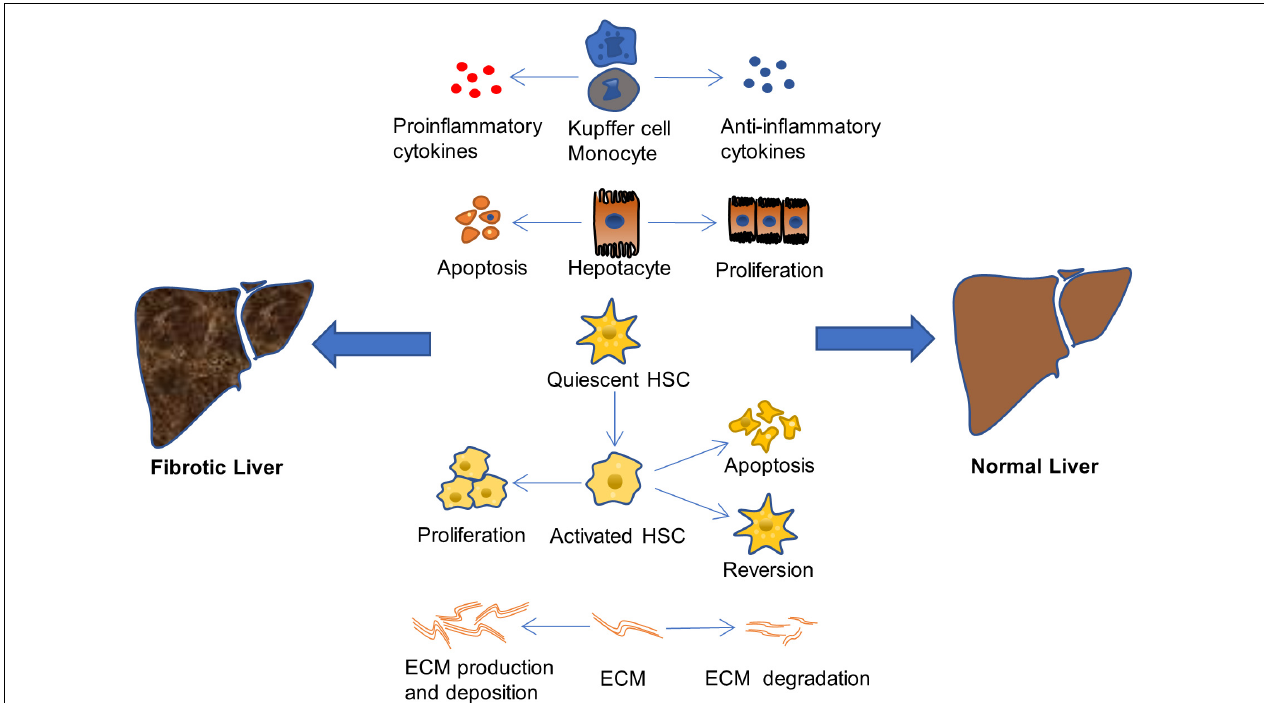
FIGURE 2 | Therapeutic approaches of liver fibrosis. The liver fibrosis is induced when the balance of pro-inflammatory/anti-inflammatory, or apoptosis/proliferation of hepatocyte and HSCs, or production and deposition/degradation of ECM is destroyed (Campana and Iredale, 2017; Roehlen et al., 2020).